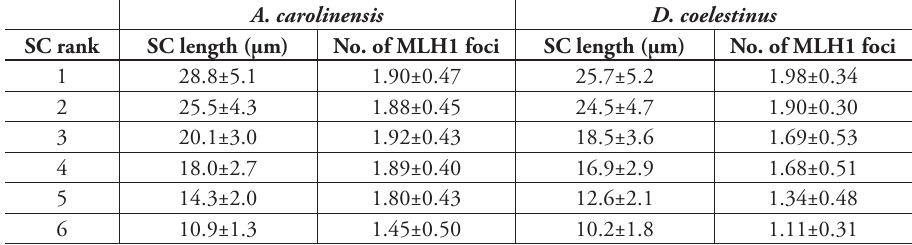
Table 1. Average SC length (µm) and of MLH1 foci number (±S.D.) in macroSCs in two anole